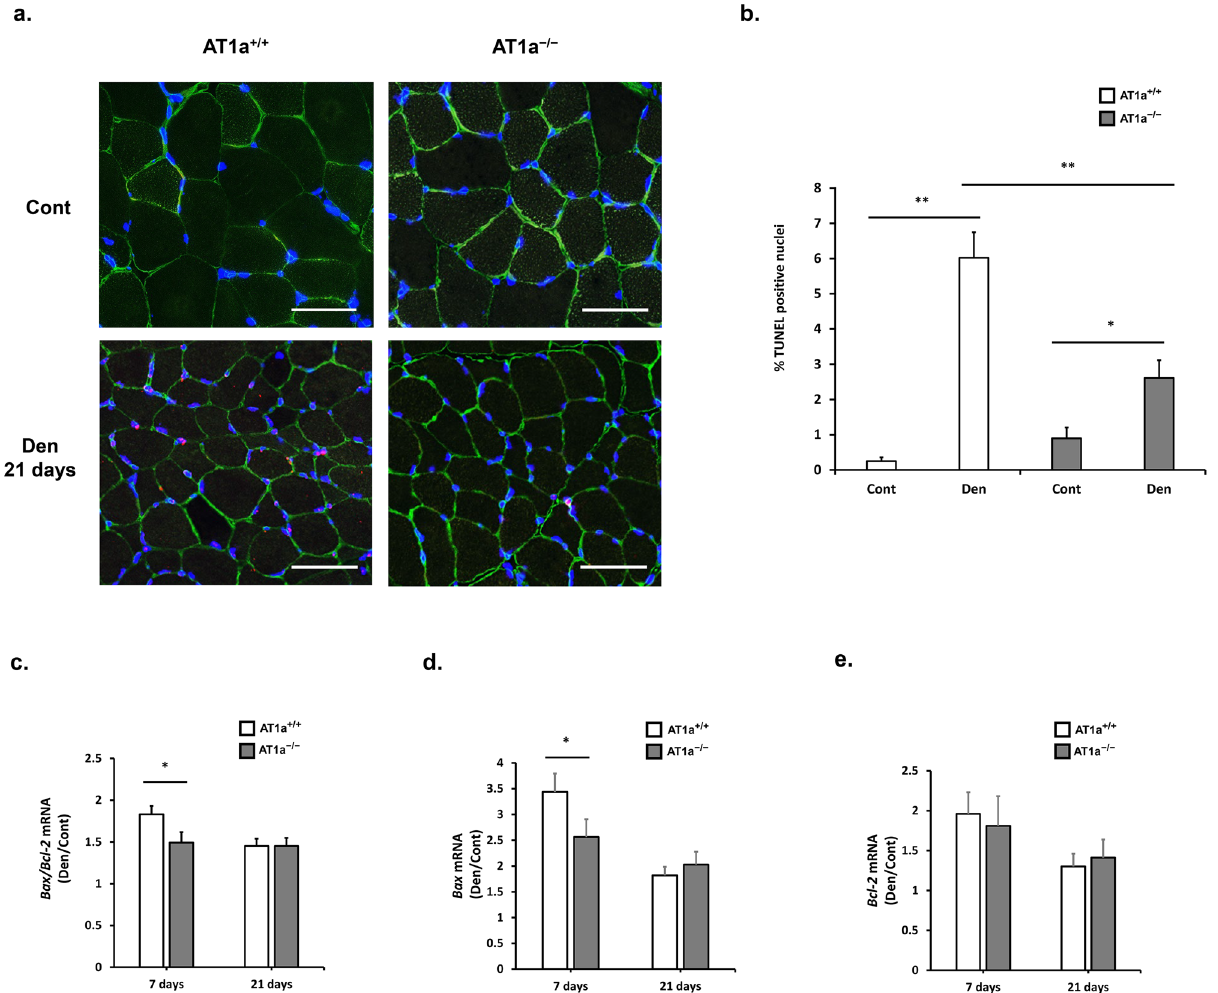
Figure 3. AT1a receptor loss mitigated apoptosis in the denervated gastrocnemius muscle. ( a ) Immunostaining of gastrocnemius muscles in each AT1a +/+ and AT1a −/− mice at 21 days postdenervation. Apoptotic cells were detected by TdT-mediated dUTP nick-end-labeling (TUNEL) staining in the denervated gastrocnemius muscles. Triple staining with TUNEL positive apoptotic nuclei (red), nuclear stained by DAPI (blue), and laminin (green). Scale bar: 50 μm. ( b ) The graphs show the ratio (%) of TUNEL-positive nuclei to all the nuclei (TUNEL- or DAPI-positive nuclei). ( c–e ) Gene expression of Bax/Bcl‑2 ratio ( c ), Bax ( d ), and Bcl‑2 ( e ) was evaluated by RT-qPCR. Expression levels of these transcripts in each sample were normalized to 18S rRNA expression levels and were shown as the fold increase or decrease in mRNA expression in the Den group compared with the Cont group. AT1a +/+ -Cont group, n = 6; AT1a +/+ -Den group, n = 7; AT1a −/− -Cont group, n = 5; AT1a −/− -Den group, n = 6. Values are means ± SE. *P < 0.05, **P < were not significantly upregulated by denervation in both AT1a +/+ and AT1a −/− mice (Fig. 5b). Serum C1q con- centration was not significantly increased by denervation in both AT1a +/+ and AT1a −/− mice (Fig. 5c). Denervation did not upregulate the gene expressions of AT1a receptor ( Agtr1a ) and angio - tensinogen in gastrocnemius muscle of AT1a +/+ mice. The renin-angiotensin system (RAS) is a candidate mediator that may promote muscle atrophy 13 . Therefore, we evaluated the gene expressions of AT1a receptor ( Agtr1a ) and angiotensinogen in gastrocnemius muscle of AT1a +/+ mice. The expression levels of these transcripts in each sample were normalized to 18S rRNA expression levels and shown as the fold increase or decrease in mRNA expression in the Den group compared with the Cont group (Fig. 6a,b). The gene expression of Agtr1a was not upregulated and the gene expressions of angiotensinogen was rather attenuated in the dener- vated gastrocnemius muscle. AT1a receptor loss reduces proinflammatory response at 3 days postdenervation in dener‑ vated gastrocnemius muscle. Because the proinflammatory response has been shown to be related to muscle atrophy 21 , the effects of AT1a receptor loss on the proinflammation in denervated gastrocnemius muscle was evaluated at 3 days postdenervation when muscle atrophy was not brought.